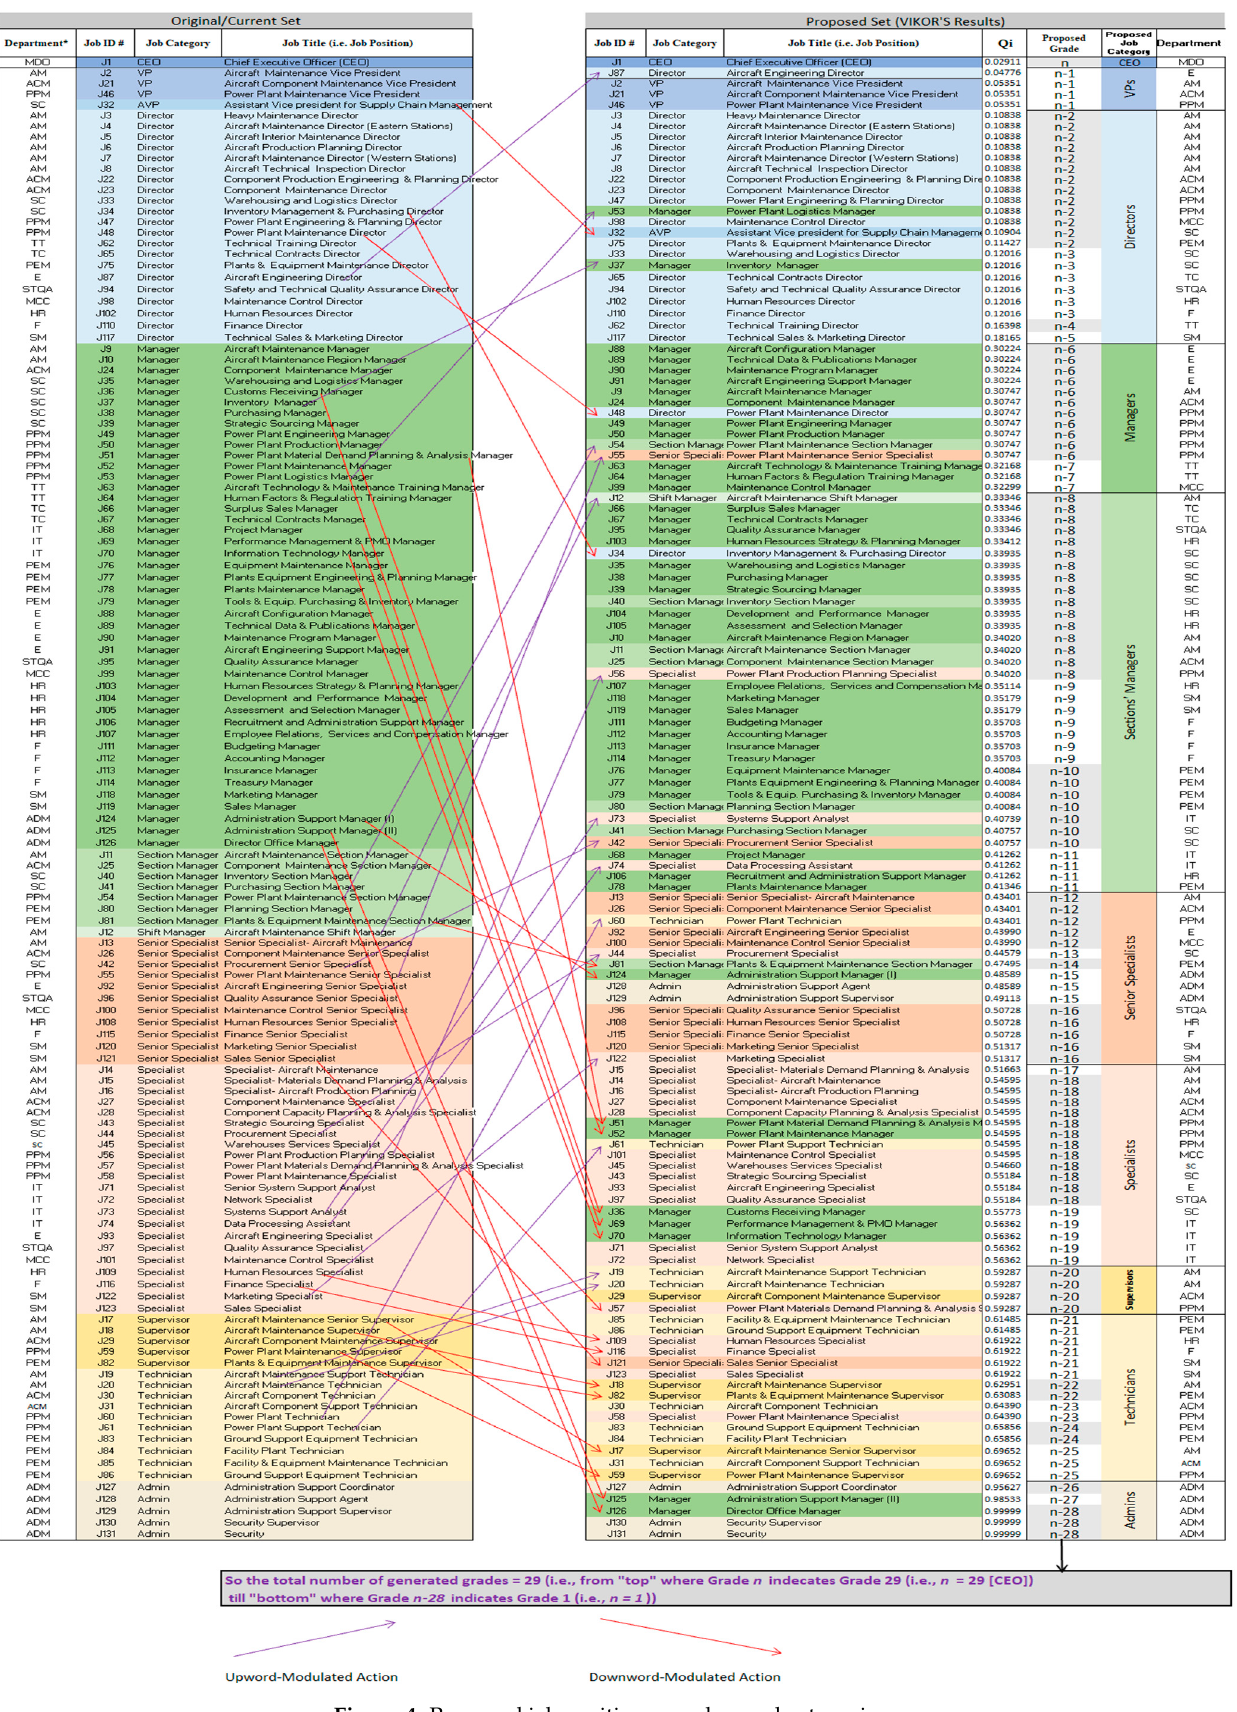
Figure 4. Proposed job positions, grades, and categories.